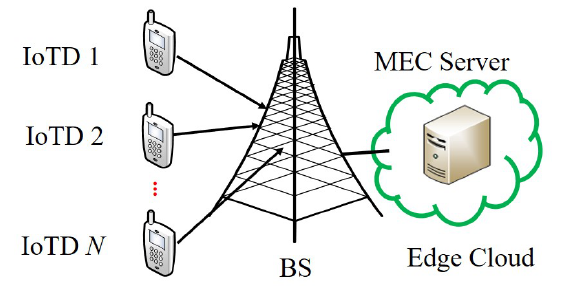
Figure 2. System